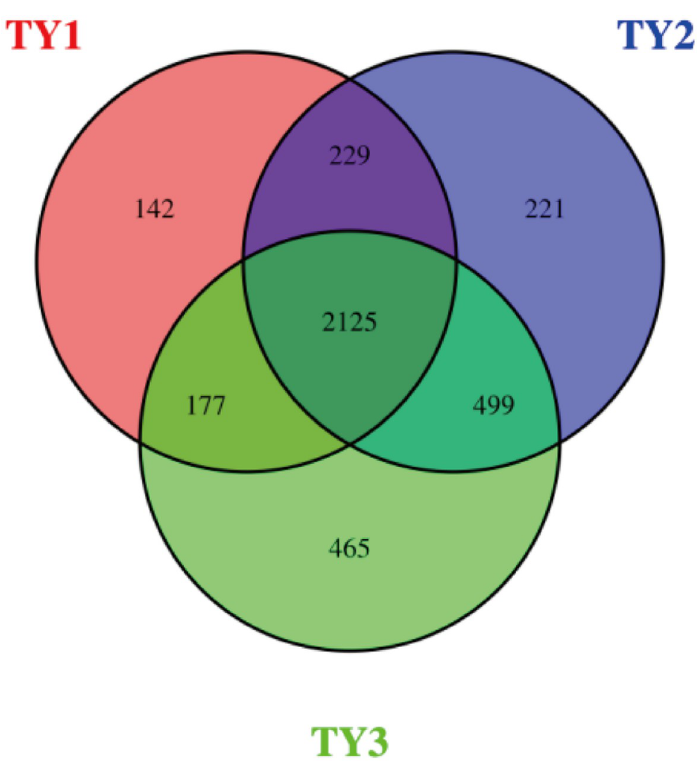
Fig 1. Venn diagram showing the distribution of OTUs in different soil samples. TY1, Tomato continuous cropping; TY2, Eggplant-tomato rotation; TY3, Arrowhead-tomato rotation.